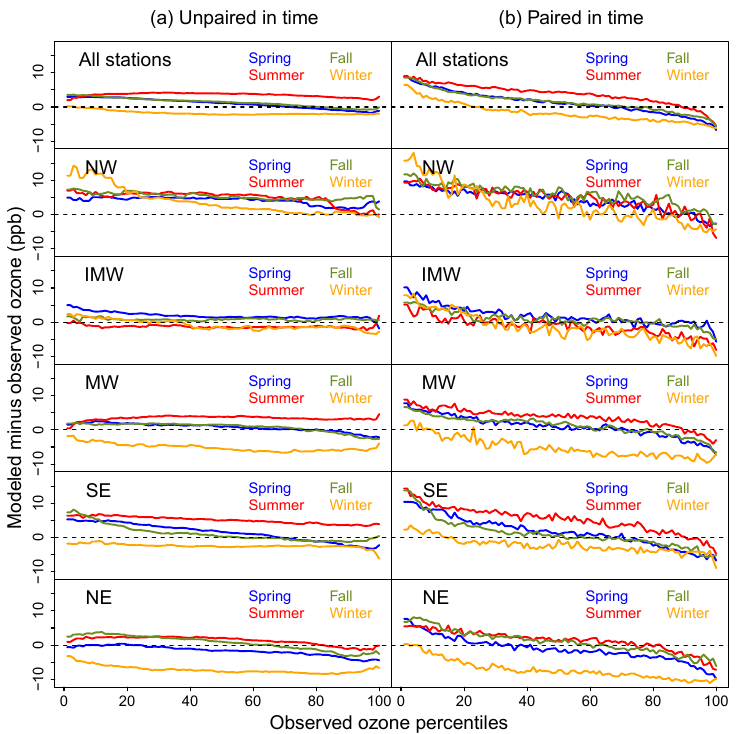
Figure 3. Differences between observed and BASE-modeled MDA8 ozone at AQS stations for each season and analysis region. For each season and region, the observed MDA8 ozone concentrations were rank ordered at each station. Next, differences between CMAQ simulations and observations were computed for each observed percentile either by selecting the model value corresponding to the date of the observed percentile (paired-in-time comparison, b ) or rank ordering the model values and then selecting the modeled percentile corresponding to the observed percentile (unpaired-in-time comparison, a ). Finally, the median value of these paired-in-time and unpaired-in-time differences across all AQS stations in a given season and region was then computed for each observed percentile and is depicted in this